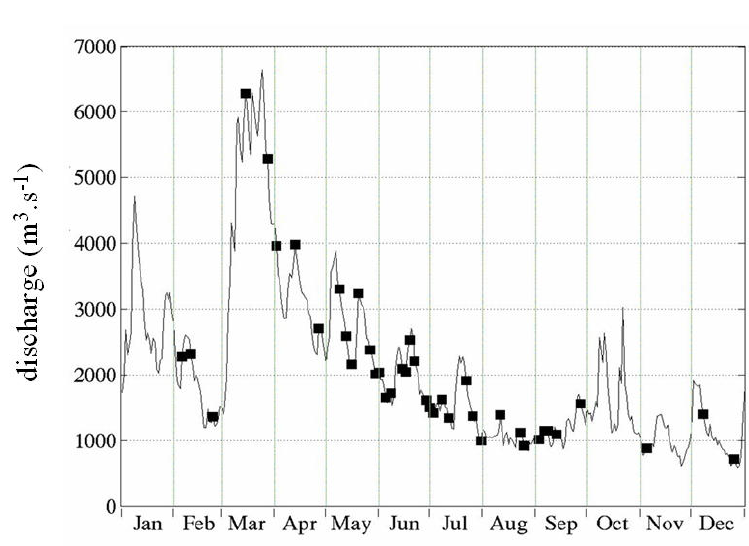
Figure 3. Daily Grand Rhône River discharge in 2001. Black boxes indicate the dates of the selected SeaWiFS